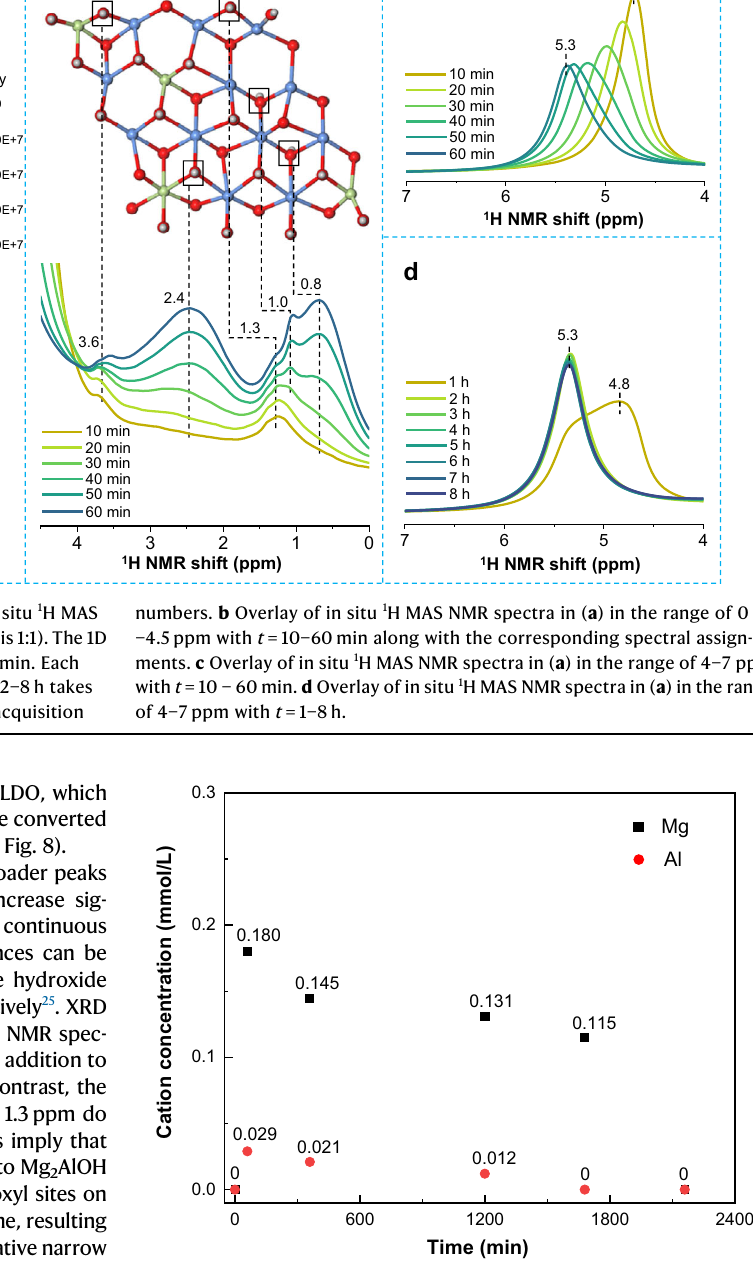
Fig. 7 | The cation concentration changes in the supernatant solution. The cationconcentrationinthesupernatantsolutionaftercentrifugationofthesample in a conventionalrecovery with rehydration time t of0min, 60min, 360min(6h), 1200min (20h), 1680 min (28h) and 2160min